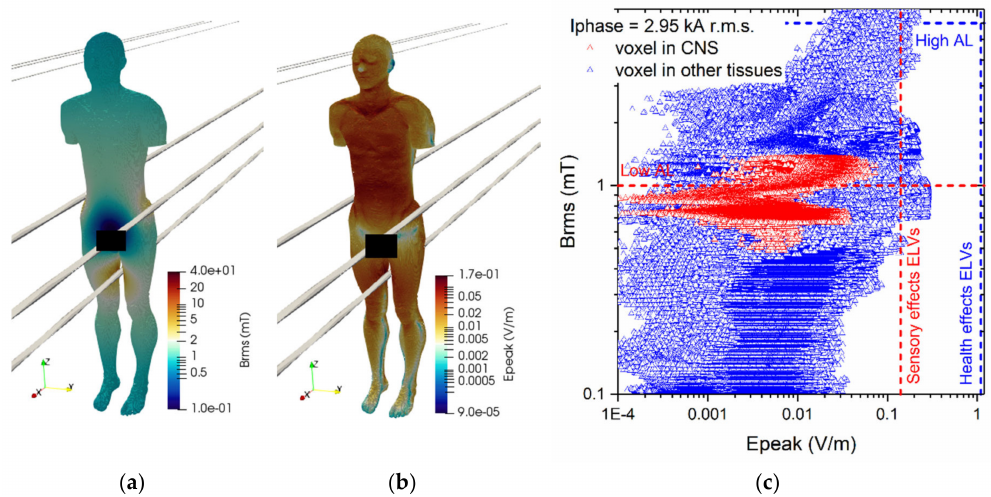
Figure 10. Results for posture A.5. On the left ( a ) the spatial distribution of the B-field amplitude (r.m.s. values in millitesla) over the body surface. In the middle ( b ) the corresponding spatial distribution of the E-field amplitude (peak values in volt per metre) over the body surface. On the right ( c ) the distribution of the voxel values.